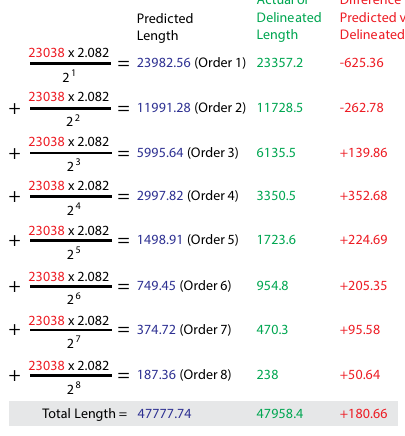
Figure 6, Refinement of Formula Deducted from Results Figure 7 refines the method used in Figure 6 into a